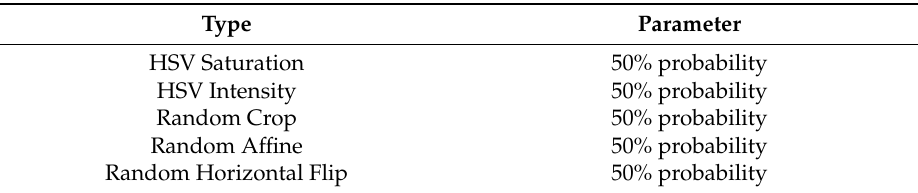
Table 3. Specific settings of data